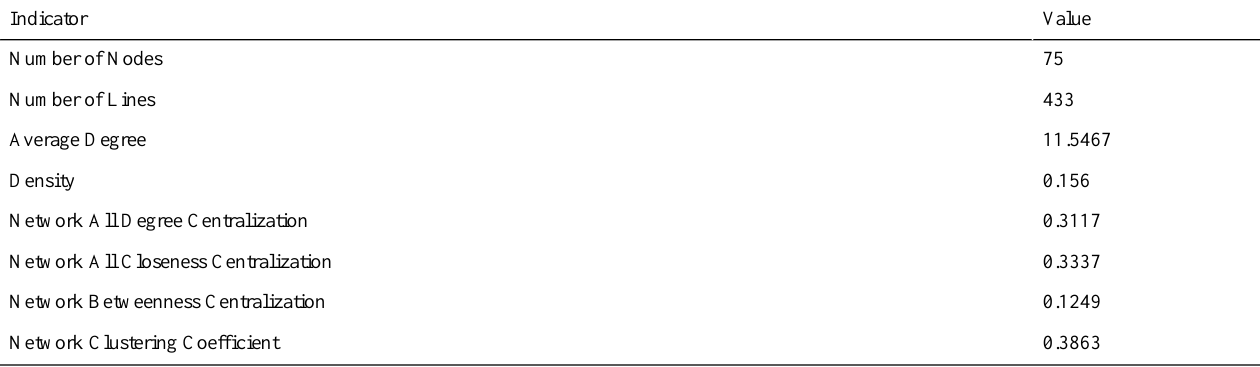
Table 3. Indicators of interdisciplinary networks in precision medicine